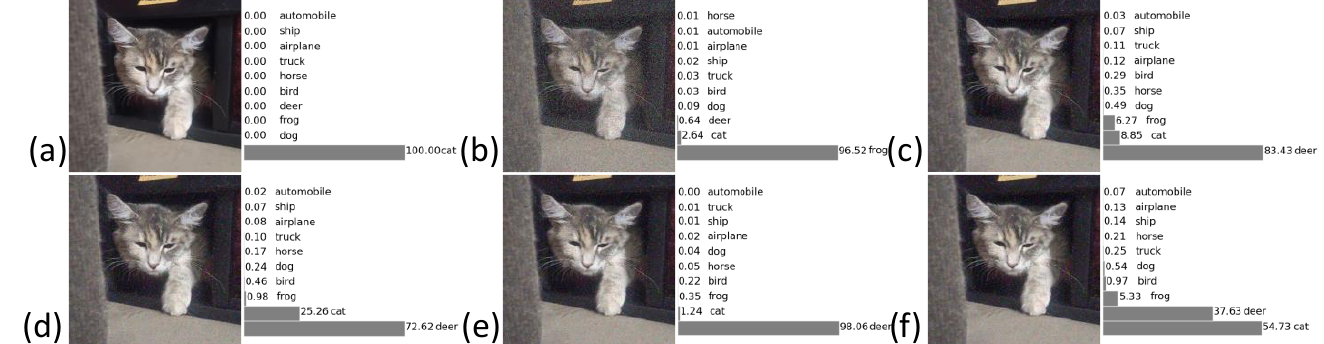
Figure 7. Results of image “ Cat_ Maine_Coon ” recognition: ( a ) original image; ( b ) image noisy with random-valued impulse noise of intensity 25%; ( c ) image cleaned by the method [28]; ( d ) image cleaned by the method [25]; ( e ) image cleaned by the method [27]; ( f ) image cleaned by the proposed method.